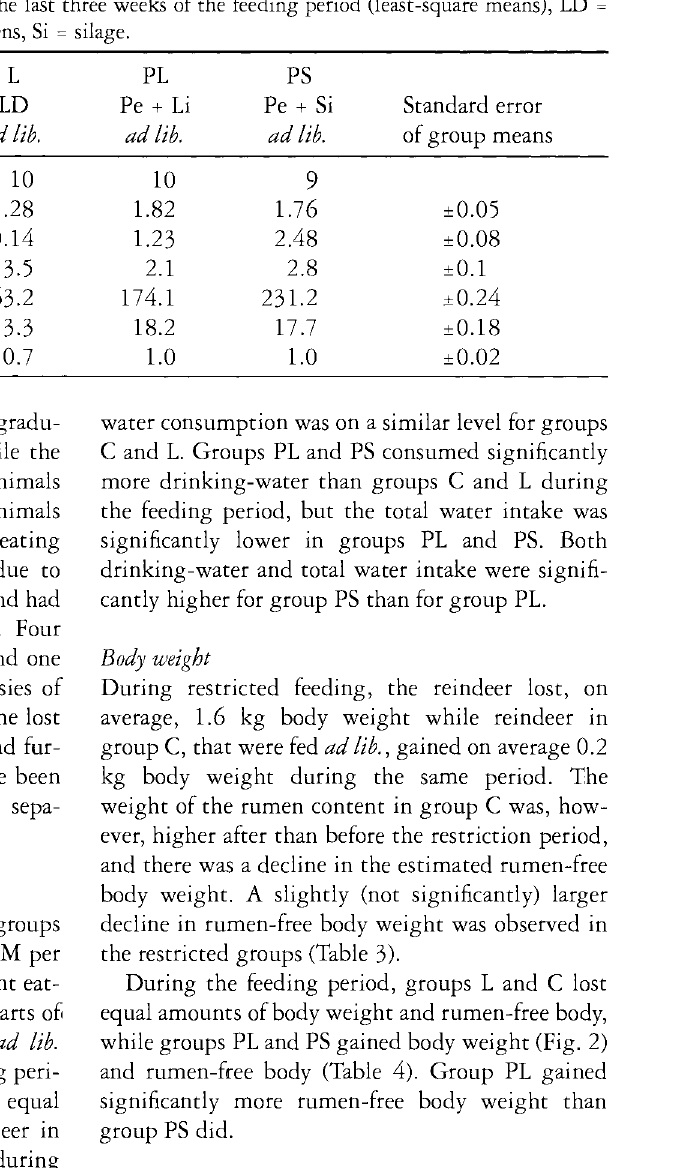
Table 2. Average daily intakes of feed, water and crude protein (CP) and calculared intake of merabolisable energy (ME) per animal in each group during rhe last three weeks of the feeding period (least-square means), LD = lichen based diet, Pe = pellets, Li = lichens, Si =